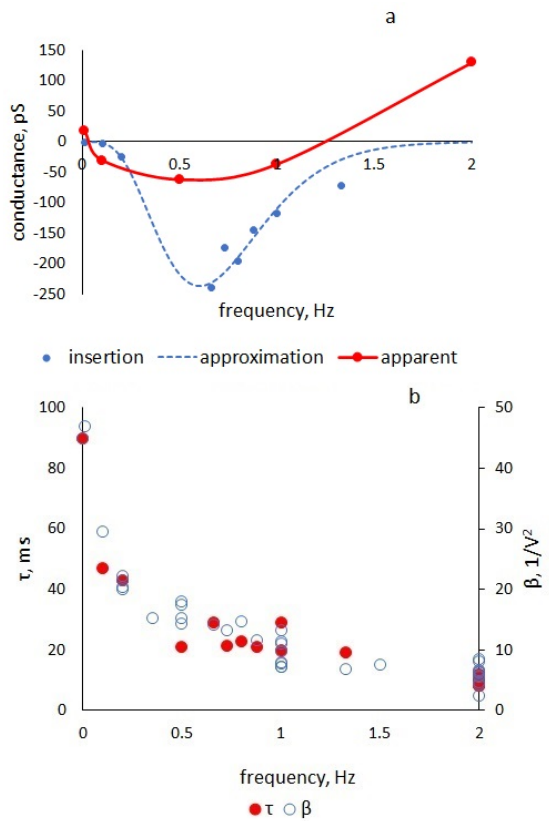
Figure 6. ( a ): Dependence of apparent and insertion conductance calculated by Formula (20) with parameters β and τ calculated from experimental data on triangular voltage frequency. The calculation did not take into account the ionic conductance of the membranes ( g = 0). ( b ): Dependence of the values of β and τ calculated from experimental data on the frequency of the triangular voltage.